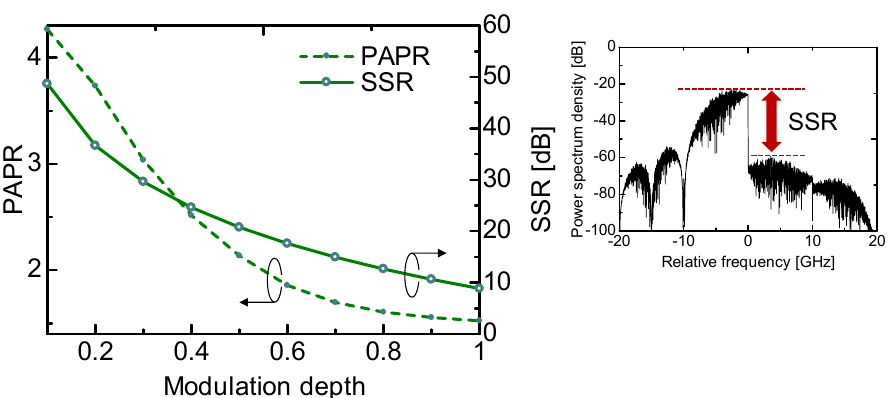
Figure 3. Waveforms and power spectra of peak-folded OSSB-SC signal, ( a ) modulator output waveforms at modulation depths of 0.1, 0.6, and 1.0, ( b – d ) power spectra of the modulator output signal at modulation depths of 0.1, 0.6, and 1.0 respectively.